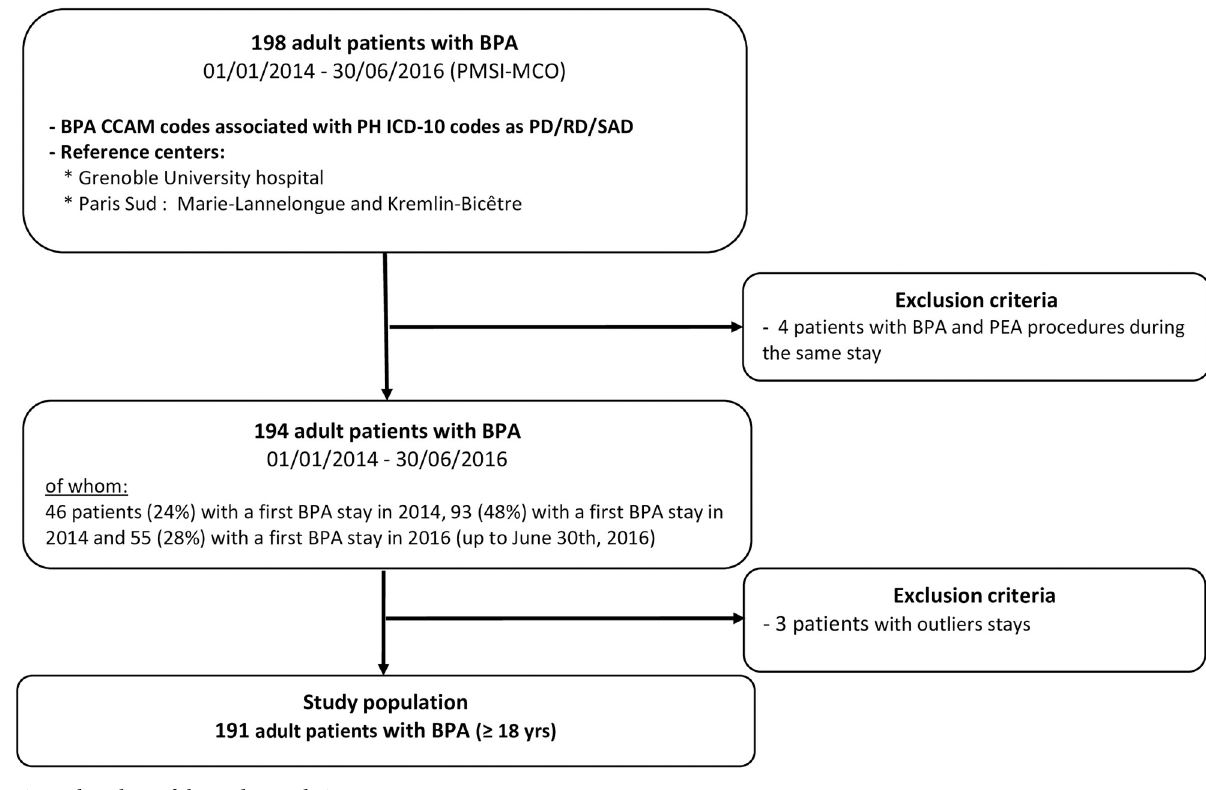
Fig 1. Flow chart of the study